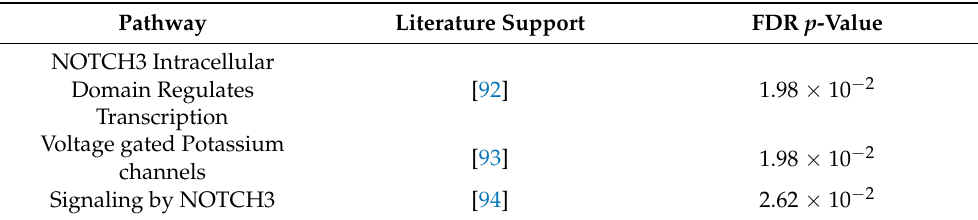
Table 5. Statistically Significantly Enriched COAD Pathways: Most enriched pathways influenced by the genes with the largest hazard ratios associated with increased risk in our TCGA-COAD Cox model. p -value threshold <0.05 FDR. Hazard ratio threshold >2.